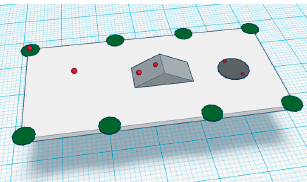
Figure 4. Target points in the workspace are shown in red, while the workspace boundary circles are shown in green.